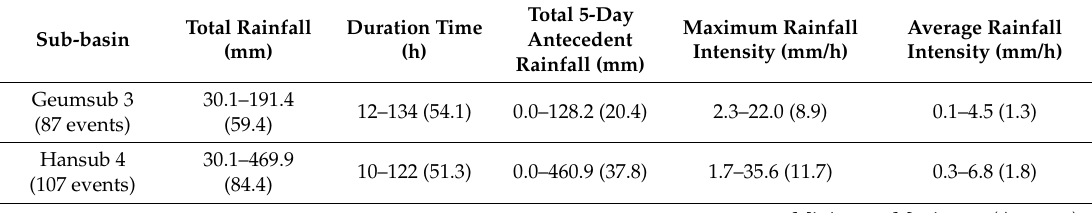
Table 5. Characteristic of the Observed Rainfall